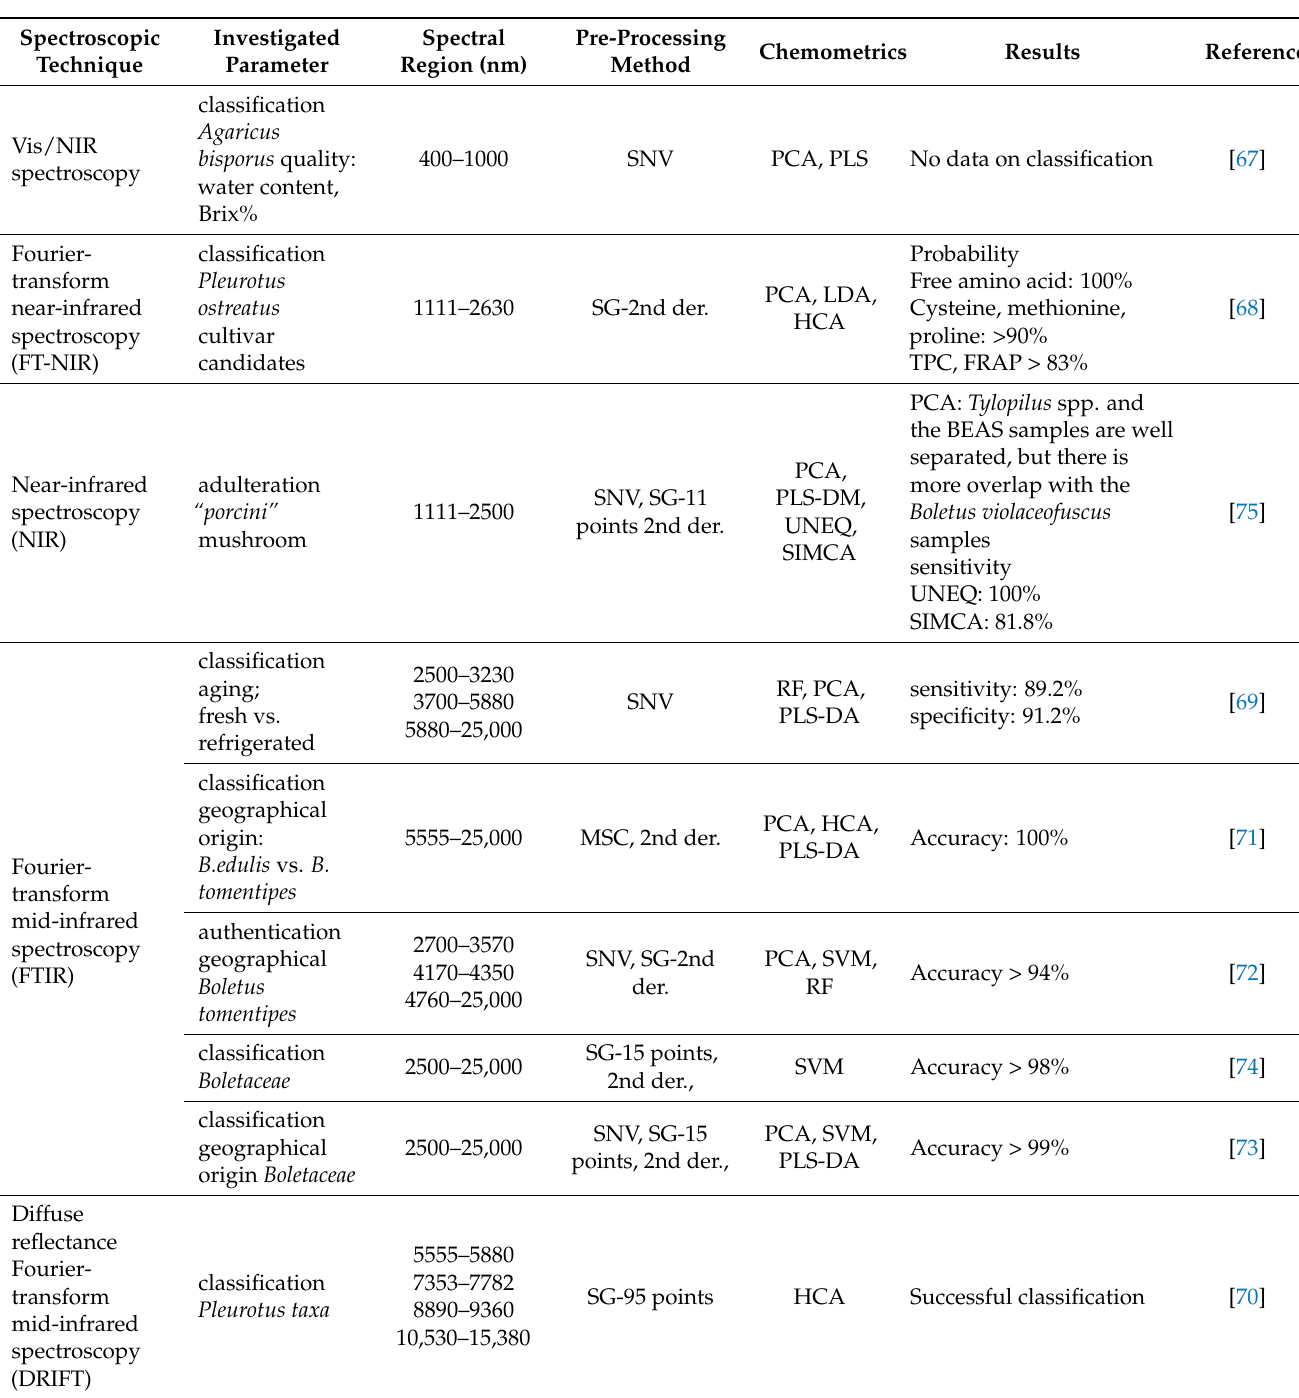
Table 5. Overview of molecular spectroscopic techniques for authentication and adulteration deter- mination in cultivated